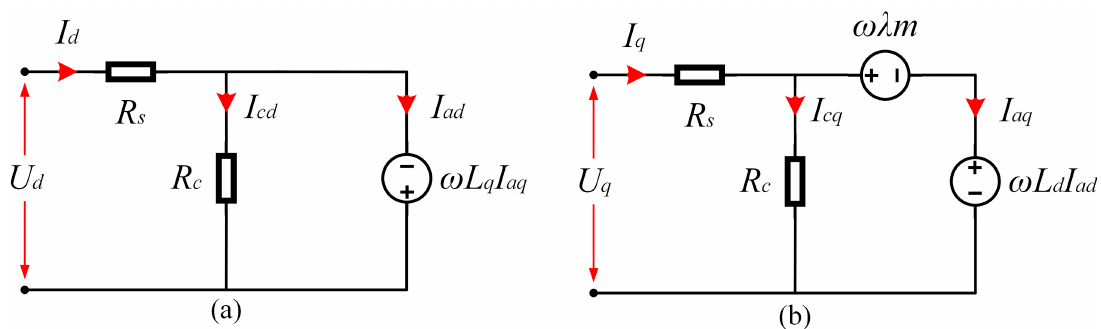
Figure 2. Steady-state equivalent d–q circuits of permanent magnet synchronous machine (PMSM) with iron loss resistance, listed as: ( a ) d-axis equivalent circuit; ( b ) q-axis equivalent circuit.